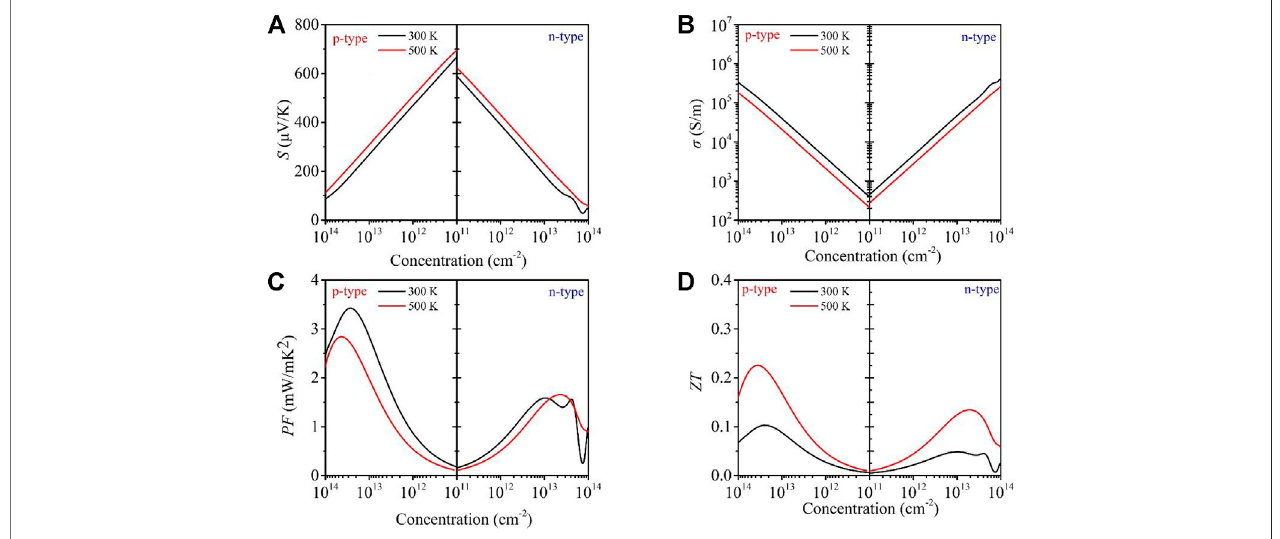
FIGURE 5 | Calculated Seebeck coef fi cient S (A) , electrical conductivity σ (B) , power factor PF (C) , and (D) ZT values as a function of carrier concentration at different temperatures (300 and 500 K, respectively) for monolayer GeS 2 .